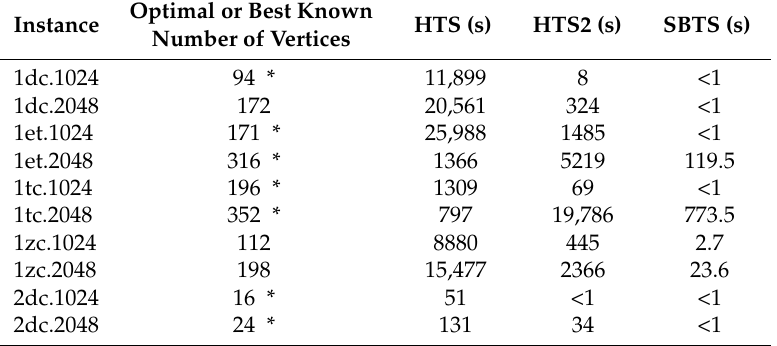
Table 6. Comparison of run times to find optimal or best known solution of Sloane, DIMACS, and permutation code instances for HTS, HTS2, and SBTS. If the solution in the second column is not achieved, the best solution found is indicated in brackets. * denotes that the best known result is